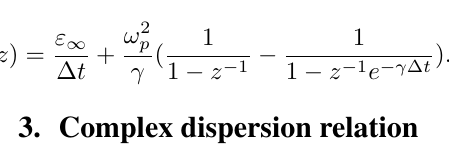
Figure 3: Dispersion relation for a thickness e = 98 nm : the normalized frequency (to the plasma frequency ω p ) in function of the real part of the propagation constant α . Taken separately, the modes have the dispersion relations in blue and